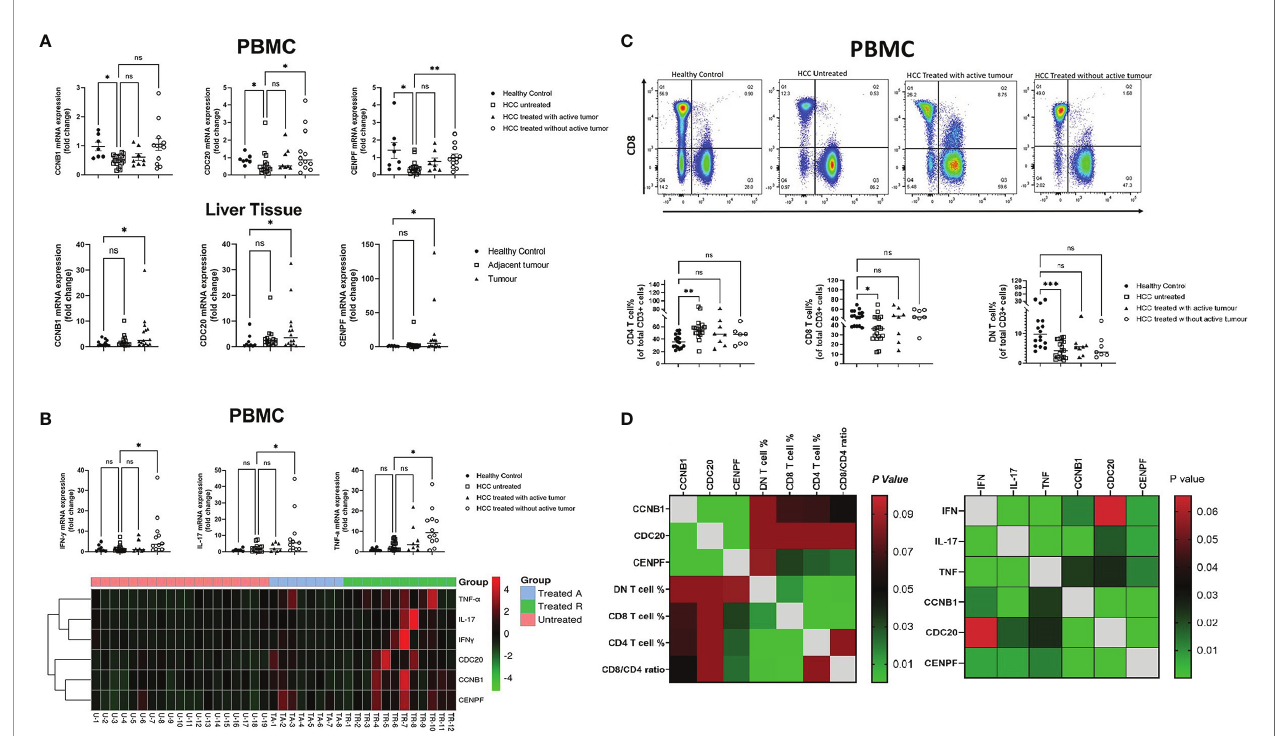
FIGURE 3 | Correlation between core genes and peripheral blood immune cells/pro-in fl ammation cytokine transcript level: (A) PCR results of three genes ’ transcript level in HCC PBMCs and liver tissue. (B) Transcript level of peripheral blood pro-in fl ammation cytokines in different subsets of HCC. (C) Percentage of three subsets of T cells, CD4+, CD8+, and double-negative (CD4-/CD8-) T cells in different HCC subgroups. (D) Correlation matrix of core genes with peripheral blood immune T cells and pro-in fl ammation cytokine transcript levels * P < 0.05, ** P < 0.01, *** P < 0.001. ns, no signi fi